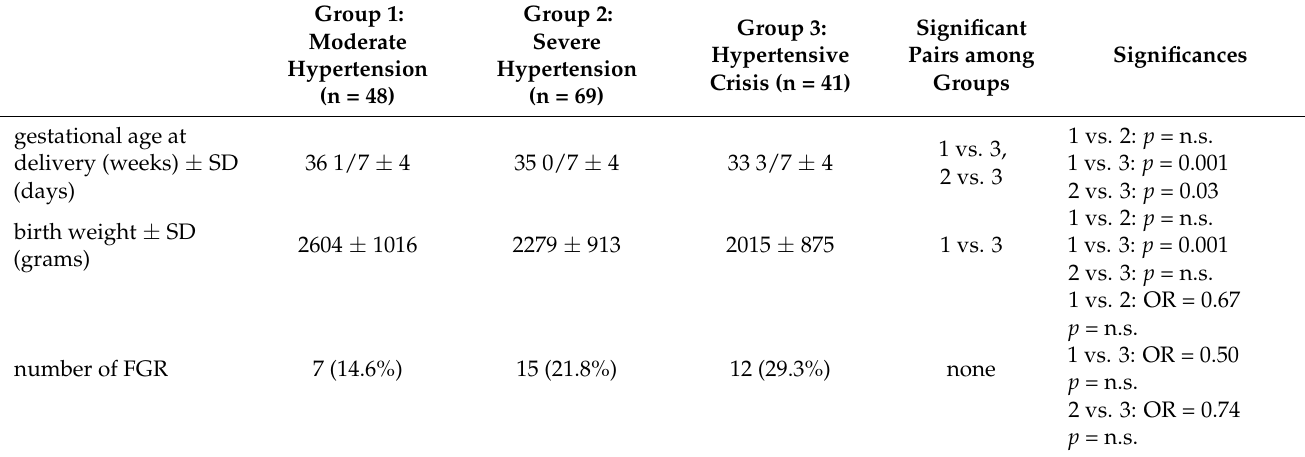
Table 2. Gestational age at delivery and birth weight within the blood pressure subgroups.